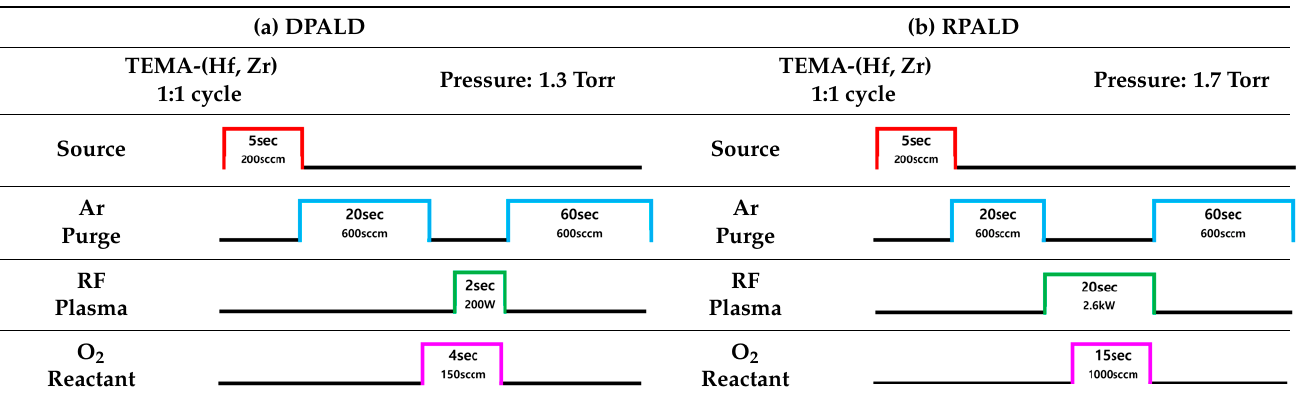
Figure 1. Concept diagrams of ( a ) DPALD and ( b ) RPALD processes, according to the plasma application method used in this study, and ( c ) photograph of the actual equipment. Table 1. Process conditions of ( a ) DPALD and ( b ) RPALD methods and a recipe for one cycle (deposition reference temperature 240 ◦ C).